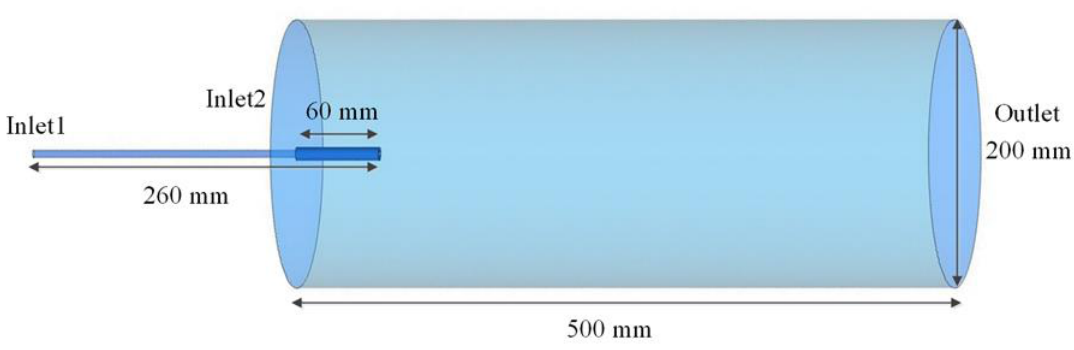
Figure 3. Calculation domain of the submerged jet.